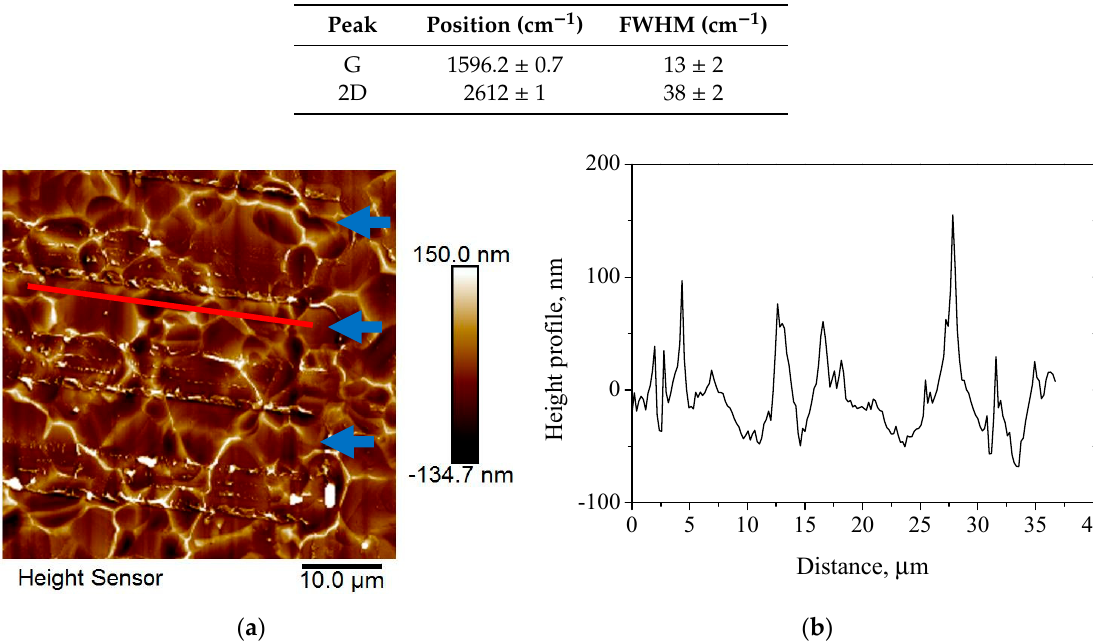
Figure 4. ( a ) AFM image of a graphene micro-ribbons supported on PMMA, and ( b ) the corresponding height profile of the inset red line. Blue arrows indicate the micro-ribbons.